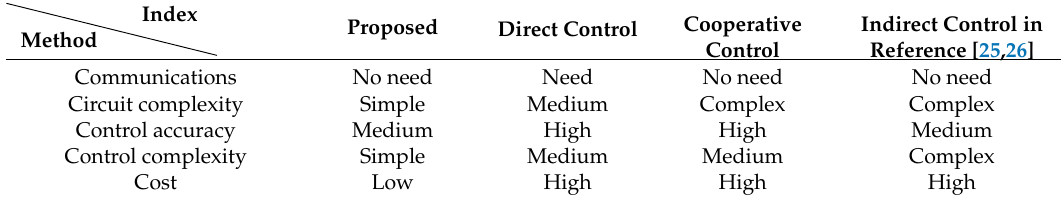
Table 3. Method comparison.